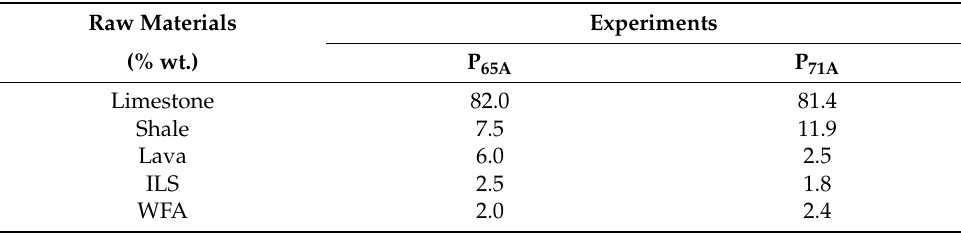
Table 2. Designed compositions for the raw meals of P 65A and P 71A .